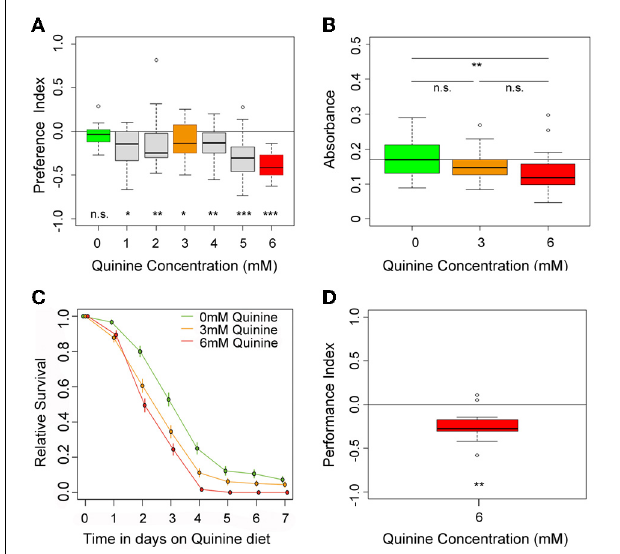
FIGURE 1 | Quinine affects larval choice behavior, feeding, survival, and associative olfactory learning. (A) Shows the dose-response curve for larval choice behavior for quinine concentrations between 0 (green) and 6mM (red). Larvae significantly avoid quinine concentrations from 1 to 6mM. (B) Depicts relative feeding on quinine. Only if 6mM (red) is mixed into the substrate, larvae reduce feeding significantly with respect to baseline feeding at 0mM quinine (indicated by the line). A lower concentration of 3mM, quinine (orange) does not significantly reduce larval food intake. (C) Larval survival on agarose-quinine mixture diet depends on the quinine concentration (Kaplan–Meier survival curves). 3mM quinine reduces larval survival compared to a pure agarose diet. The effect was even stronger for 6mM quinine as more larvae died during the experiment. (D) 6mM (red) quinine reinforces immediate negative olfactory associative learning when paired with a particular odor. Sample size for each box plot is n > 12. Differences against random distribution are given at the bottom of each panel. Differences between groups are presented above the related box-plots (n.s., non-significant p > 0 . 05, ∗ p < 0 . 05, ∗∗ p < 0 . 01, or ∗∗∗ p < 0 . 001). Small circles indicate outliers.